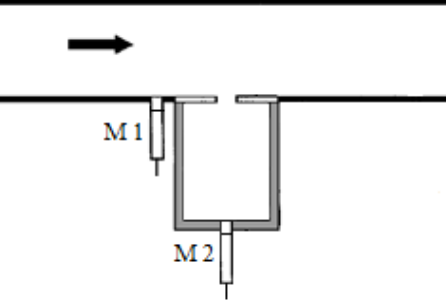
Figure 3. Scheme of measurements in the in situ method.